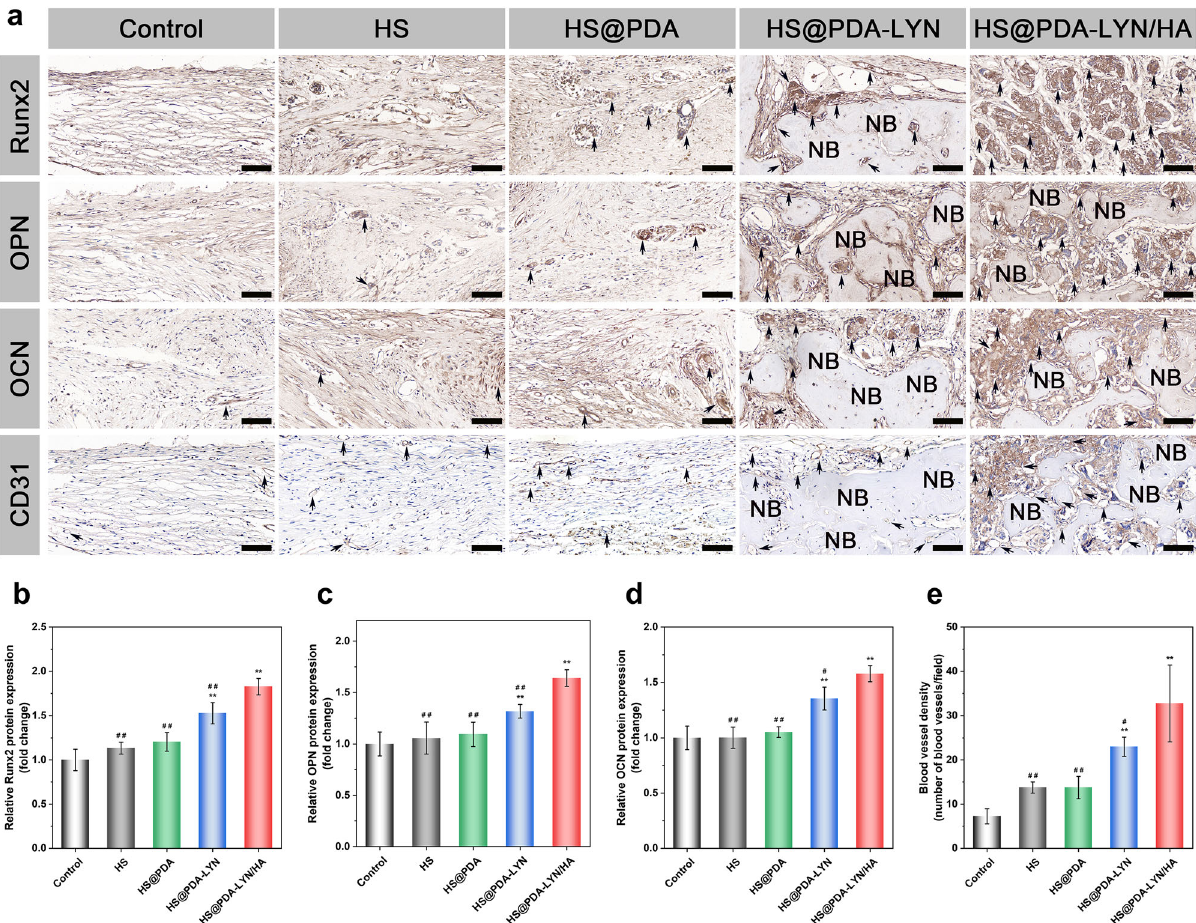
Fig. 10 Immunohistochemical staining for osteogenesis and vascularization in the calvarial defect area. a Representative immunohis- tochemical staining of Runx2, OPN, OCN, and CD31 in newly formed tissues of the defect areas at 8 weeks postimplantation. The black arrows indicate the target protein-positive zone in the defect areas. NB = newly formed bone. Quantitative analysis of b Runx2, c OPN, d OCN, and e regenerated blood vessels. Scale bar in a : 100 μ m. Data are expressed as the mean ± SD ( n = 4). * P < 0.05 and ** P < 0.01 indicate signi fi cant differences compared with the control group. # P < 0.05 and # # P < 0.01 indicate signi fi cant differences compared with the HS@PDA-LYN/ HA